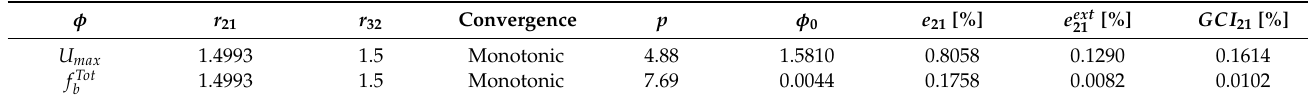
Figure 5. Mesh for the electric field (orange) and fluid mesh (black). Table 4. Mesh sensitivity study.